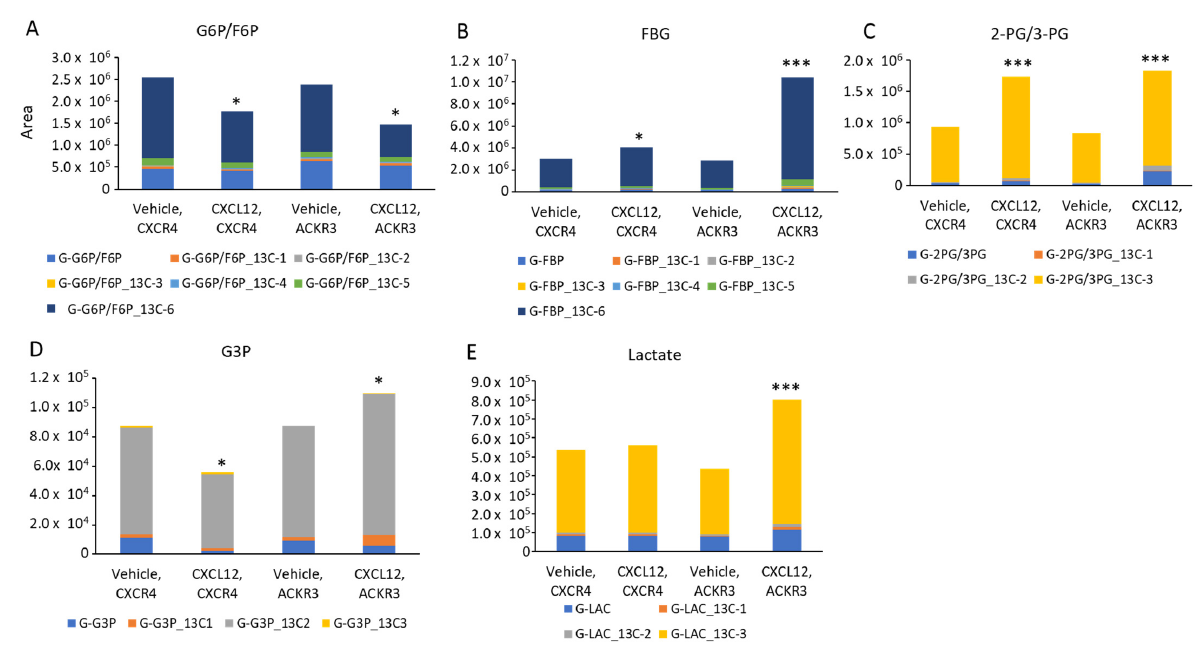
Figure 7. CXCL12 signaling through CXCR4 or ACKR3 regulates metabolites in glycolysis. We incubated MDA-MB-231 cells stably expressing CXCR4 or ACKR3 with 13 C 6 glucose and 300 ng/mL CXCL12- α or vehicle for 15 min and then harvested cells for mass spectrometry. Graphs show selected metabolites in glycolysis regulated by CXCR4 and/or ACKR3 signaling. For each graph, different colors show the metabolite and number of incorporated 13 C molecules plotted as area from mass spectrometry analysis. Total height of each bar displays the sum of all detected molecules of the listed metabolite. ( A ) glucose-6-phosphate/fructose-6-phosphate; ( B ) fructose 1,6-bisphosphate; ( C ) 2-phosphoglycerate/3-phosphoglycerate; ( D ) glyceraldehyde-3-phosphate; ( E ) lactate. * p < 0.05; *** p < 0.005.